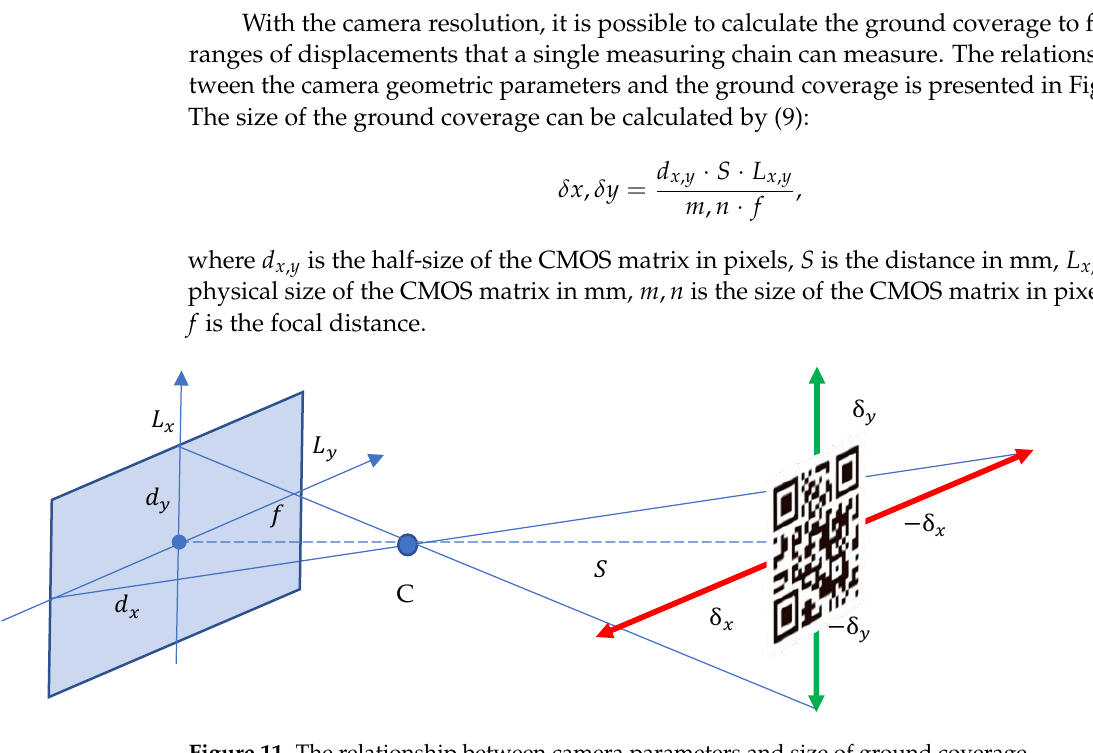
Figure 10. The resulting error graph.